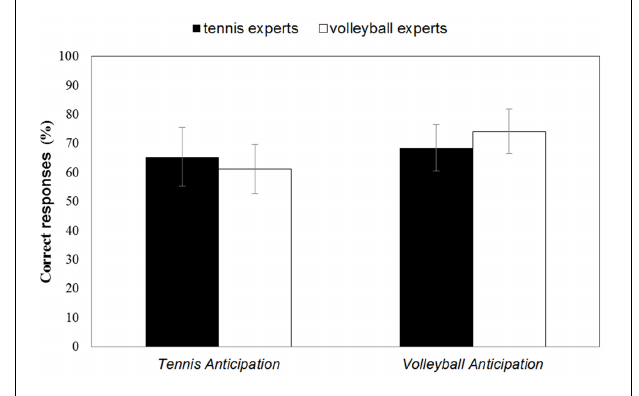
FIGURE 2 | Mean percentage of correct responses in the Tennis Anticipation and the Volleyball Anticipation condition of the tennis experts and the volleyball experts. Bars represent SD